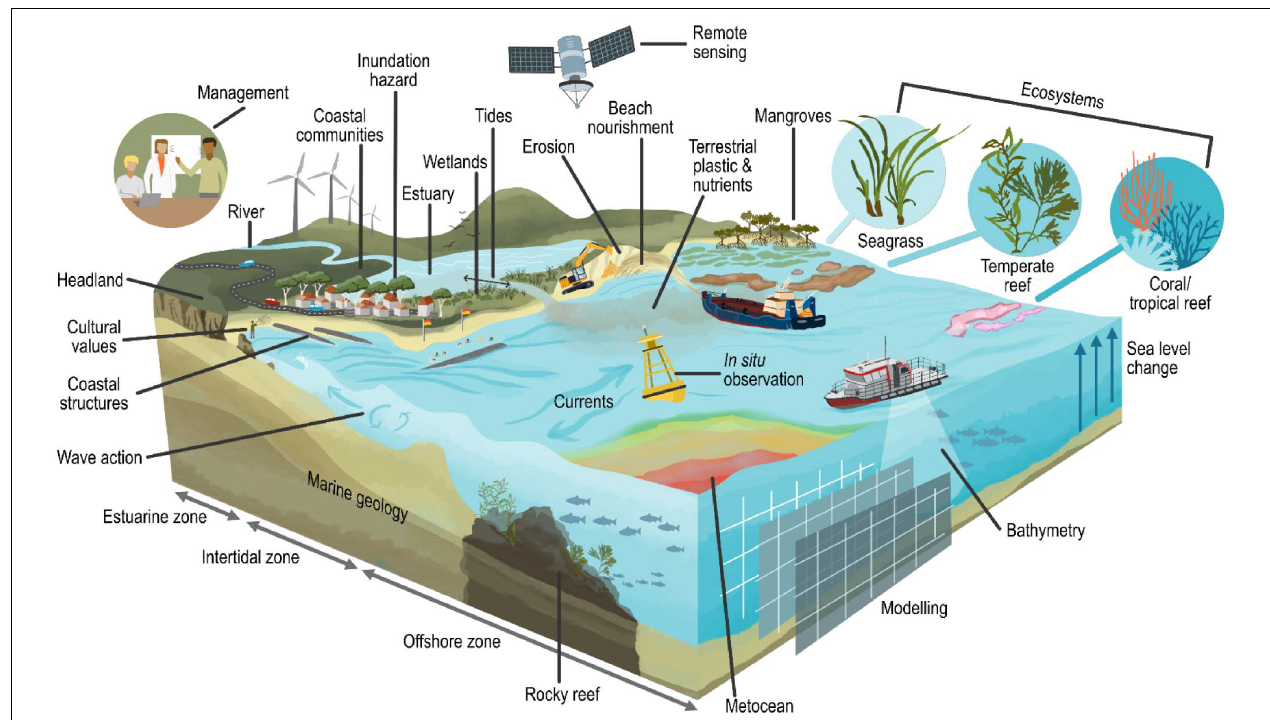
FIGURE 1 | Breadth and depth of processes, interventions, and research areas that encompass the Coastal Geoscience and Engineering community. This Figure was informed by responses to Demographic Question 10 in Surveys 1 and 2 (see Supplementary Material 1.1 and 3 and Supplementary Figures 2 , 3